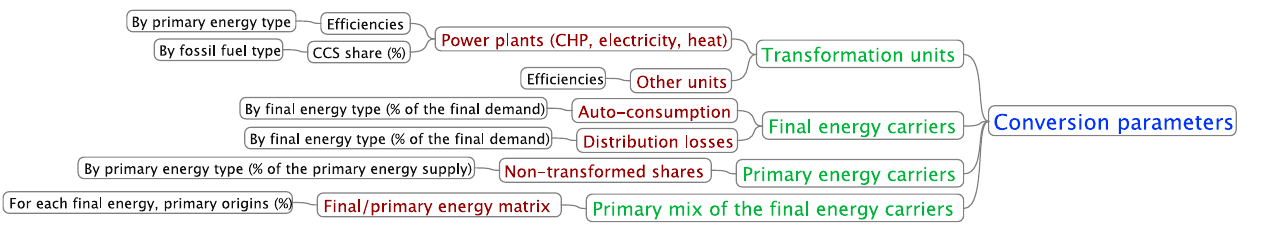
Table 4 |The conversion variables to be set in the conversion module